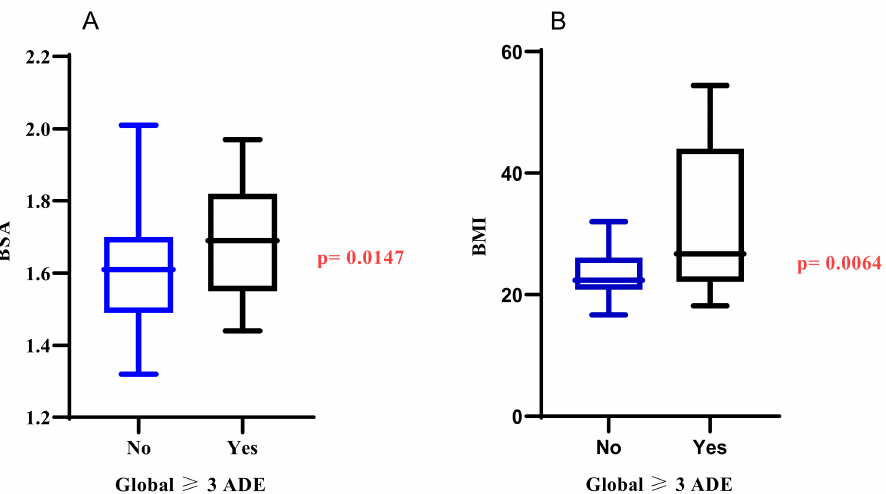
Figure 6. Association between BSA ( A ), BMI ( B ) and severe fluoropyrimidine-related adverse events markers. BSA., Body Surface Area; BMI., Body Mass Index; ADE., Adverse Drug Events; Global ≥ 3., Global severe adverse events. No., no severe global AEs. Yes., there are severe global